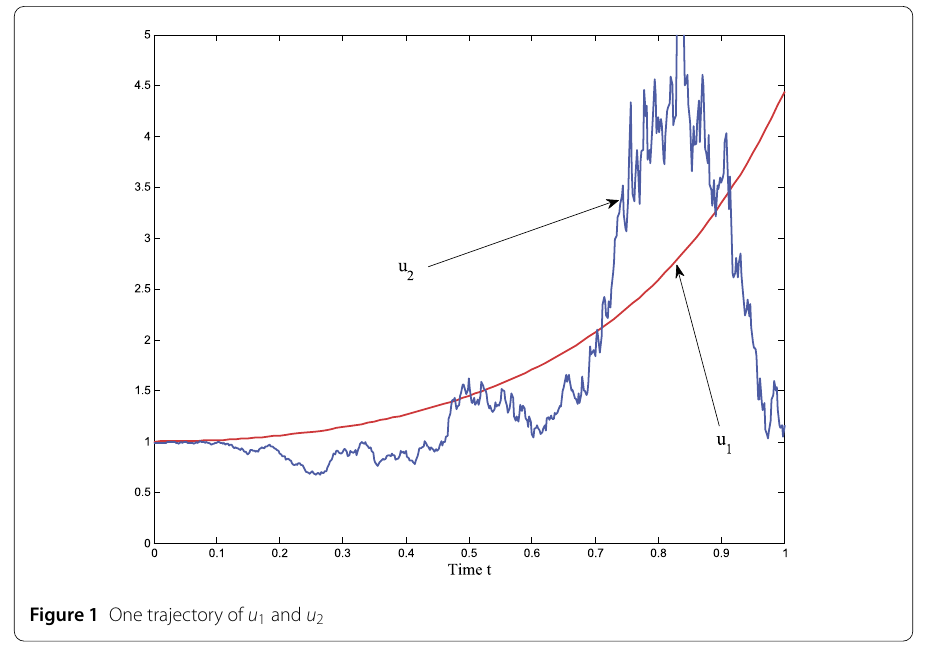
Figure 1 One trajectory of u 1 and u